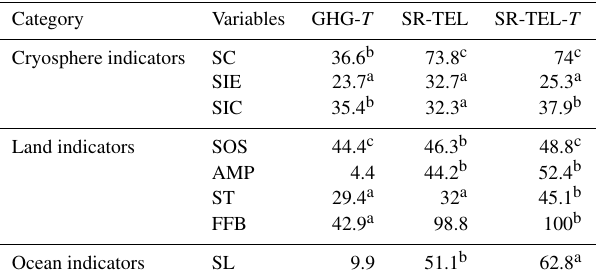
Table 4. Explained variance of land, cryosphere and ocean indica- tors by natural variability and anthropogenic forcing with and with- out temperature mediation calculated from the detrended data for